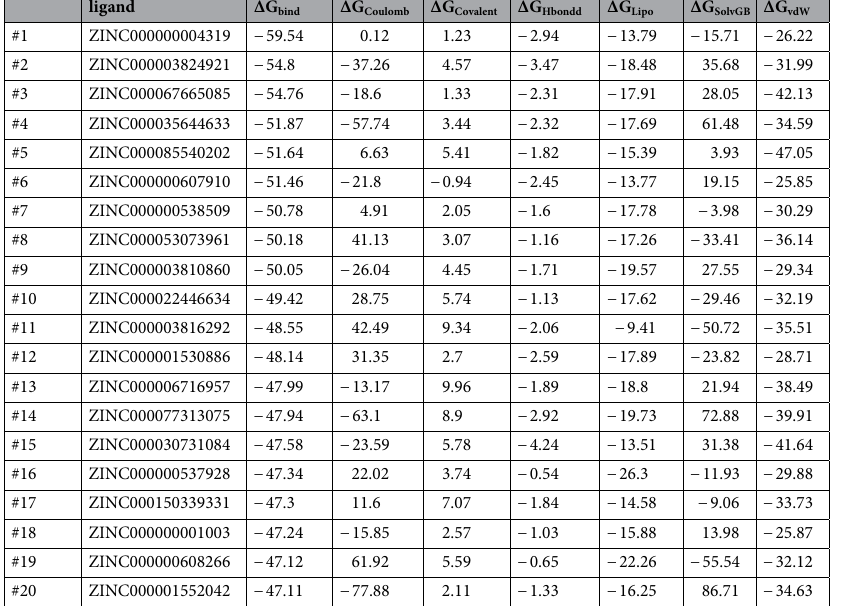
Table 2. Binding energy (kcal/mol) and individual energy terms of Delta RBD-ligand systems calculated by Prime MM-GBSA.